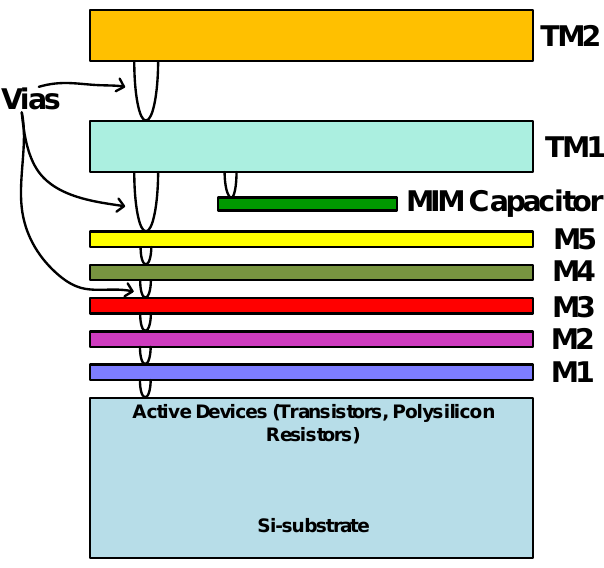
Figure 3. The 130-nm SiGe BEOLprocess cross-section